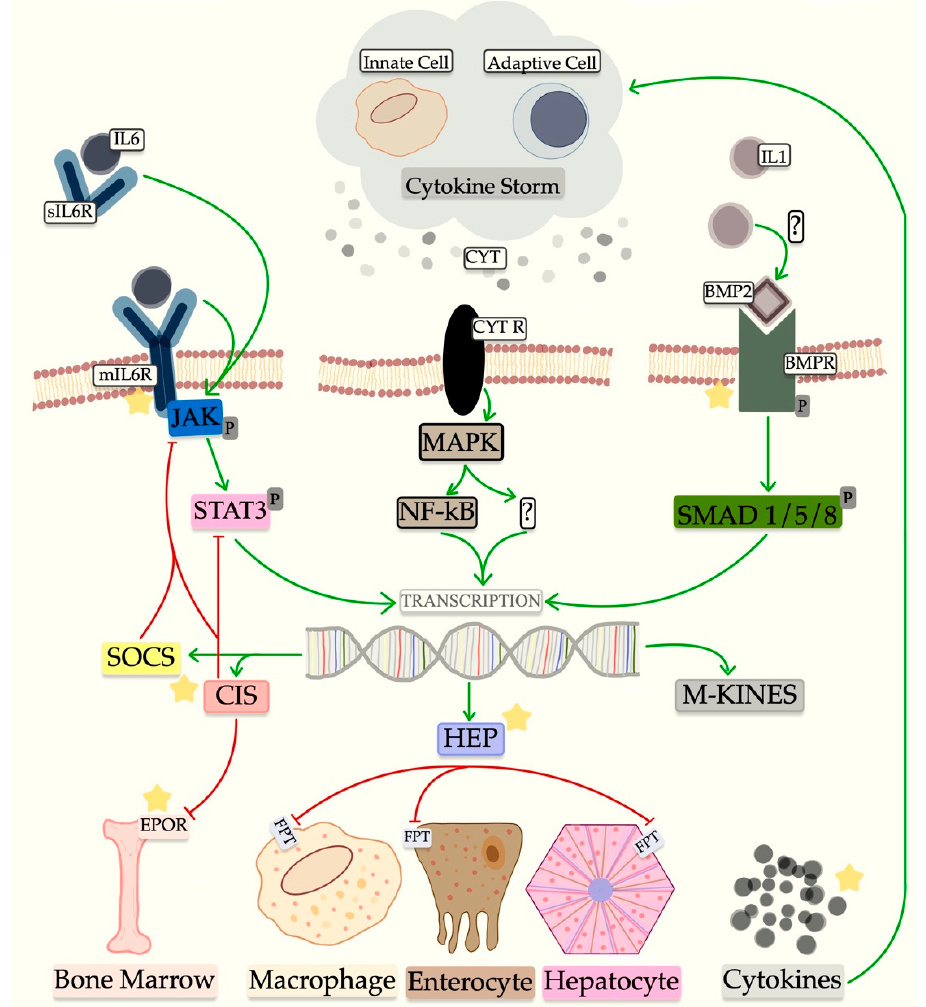
Figure 5. Cytokine storm. An array of cytokines is produced because of the viral insult. Most important cytokines are believed to be IL-6 and IL-1 with their respective signaling mechanisms. Alternatively, the MAPK/NF- κ B pathway could play a role, but the cytokines involved are less known. In the end, anemia, hyperferritinemia and cytokine storm ensue. Receptors and their respective signaling mechanisms as well as their downstream products could represent potential therapeutic targets. Potentially, essential therapeutic targets are marked with yellow star and include IL-6, IL-1, BMP2 and BMPR, JAK, STAT3, SOCS, CIS, EPOR, CYT and CYT R, MAPK, NF- κ B, SMAD1/5/8, HEP; IL-6 = interleukin 6; IL-6R = interleukin 6 receptor; JAK = Janus kinase; p = phosphorus; STAT3 = signal transducer and activator of transcription 3; SOCS = suppressor of cytokine signaling proteins; CIS = cytokine inducible SH2; EPOR = erythropoietin receptor; CYT = cytokine; CYT R = cytokine receptor; MAPK = mitogen activated protein kinase; NF- κ B = Nuclear factor kappa B; ? = unknown mechanism; HEP = hepcitin; FPT = ferroportin; IL-1 = interleukin 1; BMP2 = bone morphogenic protein 2; BMPR = bone morphogenic protein receptor; SMAD1/5/8 = mothers against decapentaplegic family protein 1/5/8; M-KINES = monokynes.